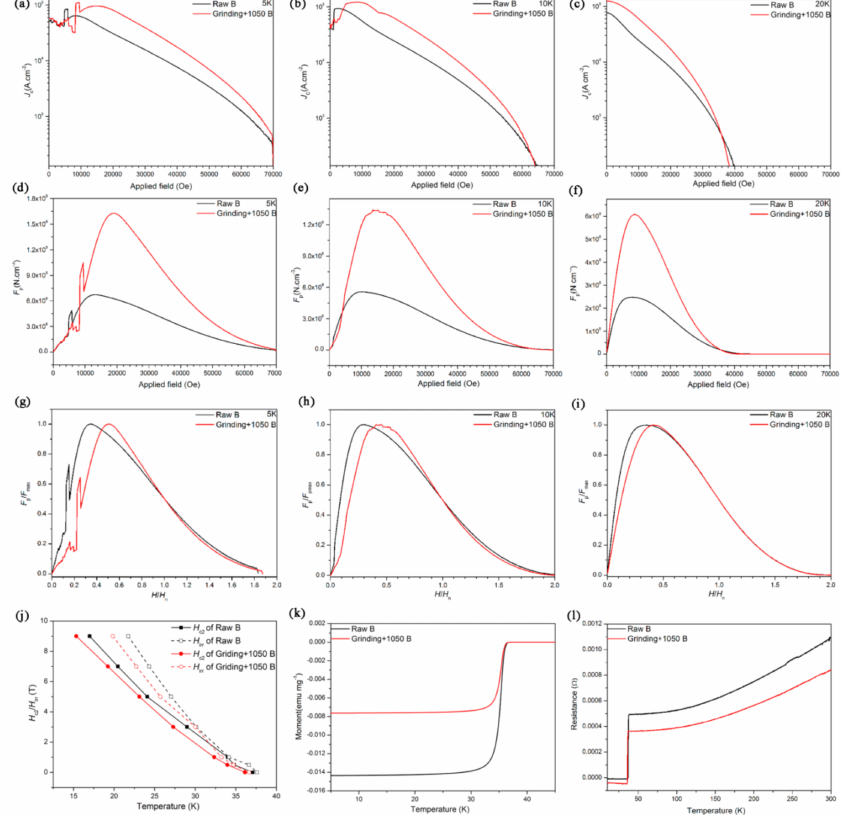
Figure 5. Superconducting properties of MgB 2 bulk with B powder of different sizes. ( a ) J c vs. applied field at 5 K; ( b ) flux pinning force ( F p ) vs. applied field at 5 K; ( c ) F p / F p max vs. H / H n curve at 5 K; ( d ) J c vs. applied field at 10 K; ( e ) flux pinning force ( F p ) vs. applied field at 10 K; ( f ) F p / F p max vs. H / H n curve at 10 K; ( g ) J c vs. applied field at 20 K; ( h ) flux pinning force ( F p ) vs. applied field at 20 K; ( i ) F p / F p max vs. H / H n at 20 K; ( j ) irreversible field ( H irr ) and upper critical field ( H c2 ) vs. temperature curve; ( k ) magnetization vs. temperature curve; ( l ) resistance vs. temperature